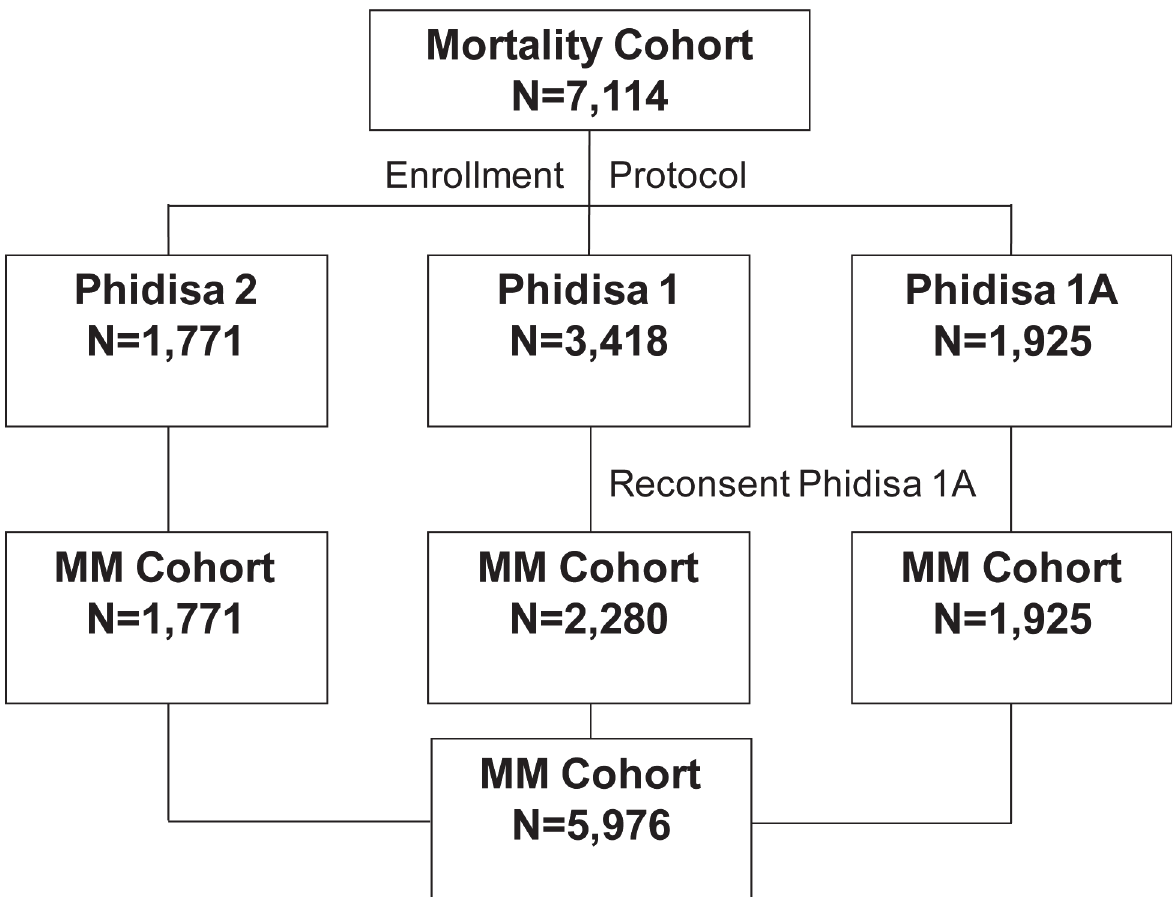
Fig 1. Phidisa Mortality and Morbidity and Mortality (MM) Cohorts. The mortality cohort is made up of 7,114 HIV+ participants: 1,771 enrolled into Phidisa 2 (the clinical trial), 3,418 into Phidisa 1 (cohort study) and 1,925 into Phidisa 1A (cohort study). Of these 7,114 participants, 5,976 participants were in the morbidity and mortality cohort. This includes the 1,771 participants from Phidisa 2, the 1,925 participants from Phidisa 1A and 2,280 participant form Phidisa 1 who reconsented into Phidisa 1A. The participants excluded from the MM cohort are the 1,138 participants enrolled in Phidisa 1 only in which morbidity data was not